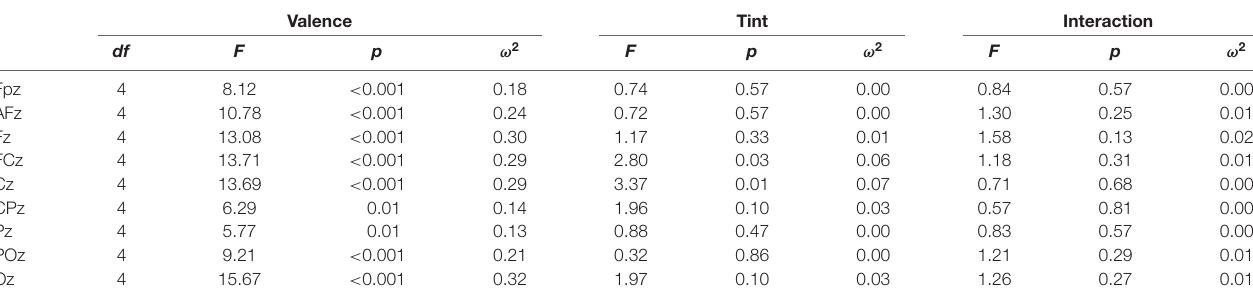
TABLE 1 | Analysis of variance (ANOVA) of Late-Positive-Potential (LPP) (500–1,500 ms) for central electrodes. Valence Tint Interaction